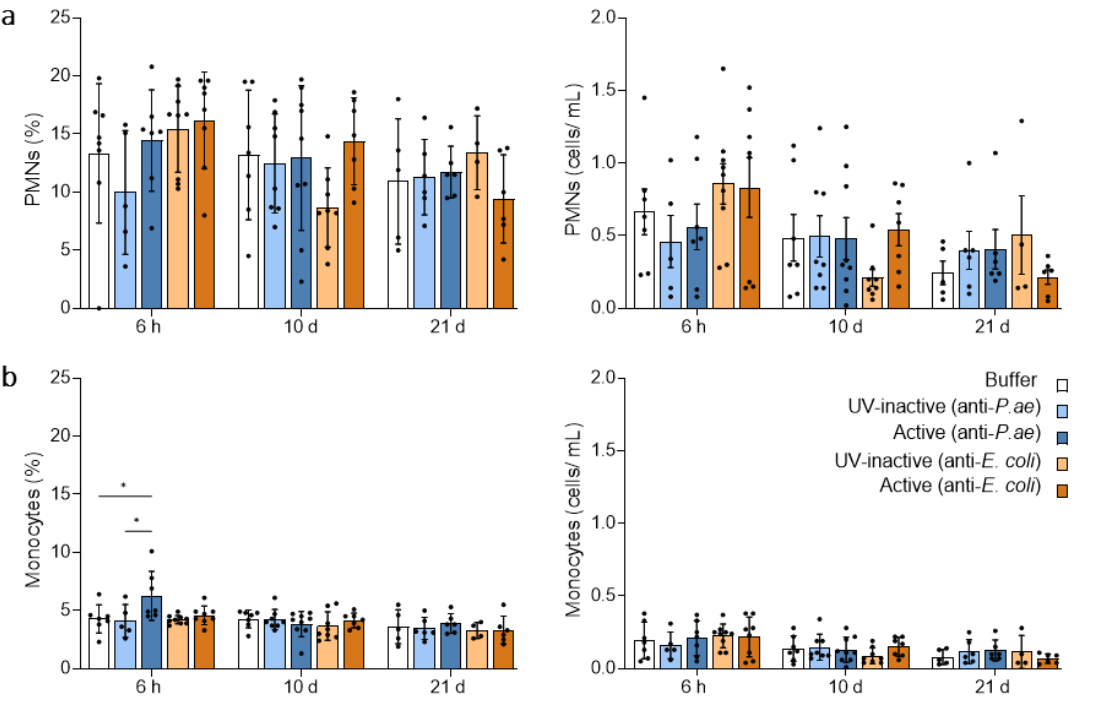
Figure 2. Blood PMNs remain largely unaffected by phage treatment. Bar graphs depicting the percentage and cells/mL of PMNs ( a ) and monocytes ( b ) in whole blood at 6 h, 10 d and 21 d time points as determined per complete blood count. Results are shown as mean ± SD, as determined by 2-way ANOVA with Tukey’s multiple comparisons test: * p < 0.05; n = 5–9 mice per group. PMNs, polymorphonuclear